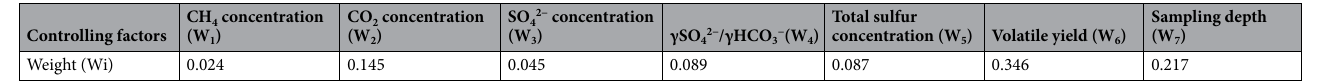
Table 7. Weight of main factors controlling H 2 S concentration.